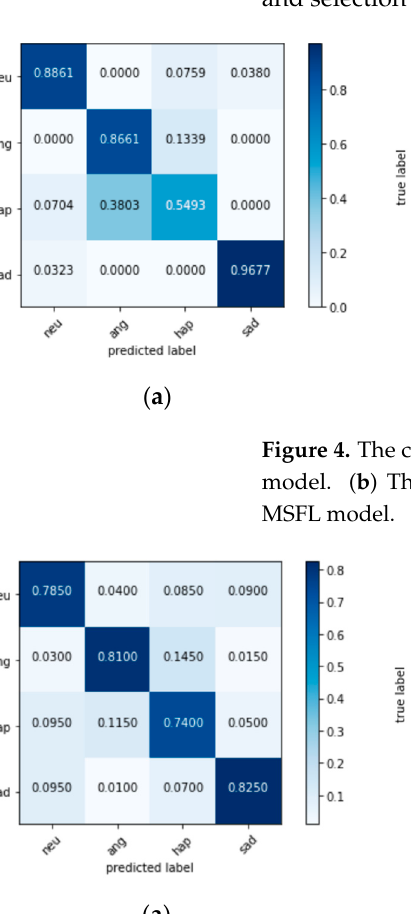
© Figure 6. The confusion matrix of the SAVEE corpus. ( a ) The confusion matrix for the MSFL_ST model. ( b ) The confusion matrix for the MTL_DNN model. ( c ) The confusion matrix for the MSFL model. 5.3. Experiment III: Multilingual Shared Features Ranking and Analysis One of the advantages of the MTL is that it can exploit shared low-dimensional rep- resentations in multiple related tasks to improve the performance of all or some of the tasks. In this study, the MTL learns MSFs in language recognition and emotion recognition to enhance SER. To further investigate the similarities and differences between the MSFs learned from the MSFL and the monolingual feature representations learned from MSFL_ST, we first obtain the feature weights from the attention mechanism layer.